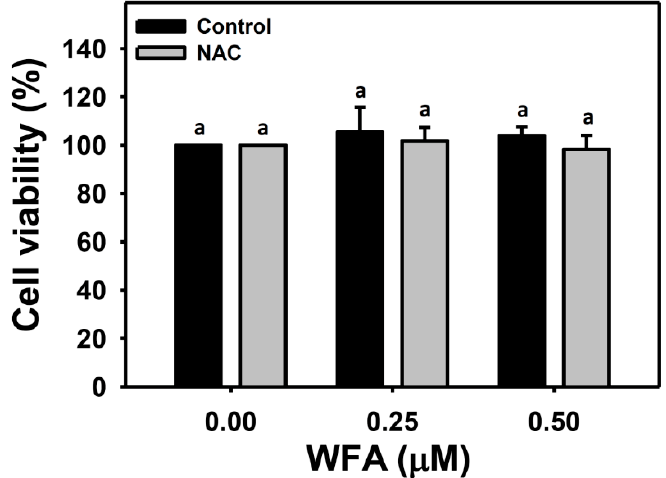
Figure 1. Viability of low concentration of Withaferin A (WFA) treatment in oral cancer cells. Oral cancer cells (Ca9-22) were pretreated with or without N -acetylcysteine (NAC) (2 mM, 1 h) and post-treated with different concentrations of WFA for 24 h. For multiple comparison, treatments with the same letter character show nonsignificant difference. Data, mean ± SD ( n = 3).